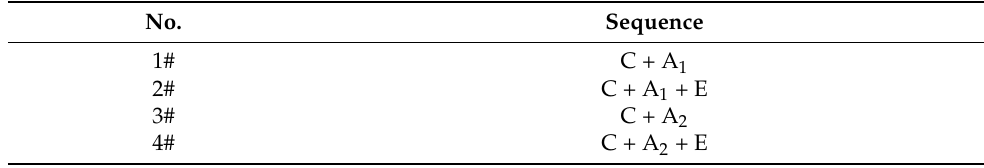
Table 2. The treatments for sample 1# to